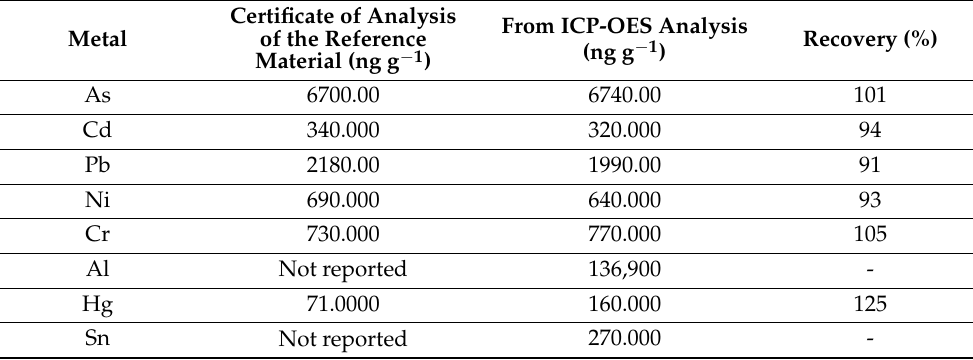
Table 2. Metal concentration reported in the certificate of the reference material, metal concentra- tion in the certified reference materials by ICP-OES and percentage of metal recovery from the reference